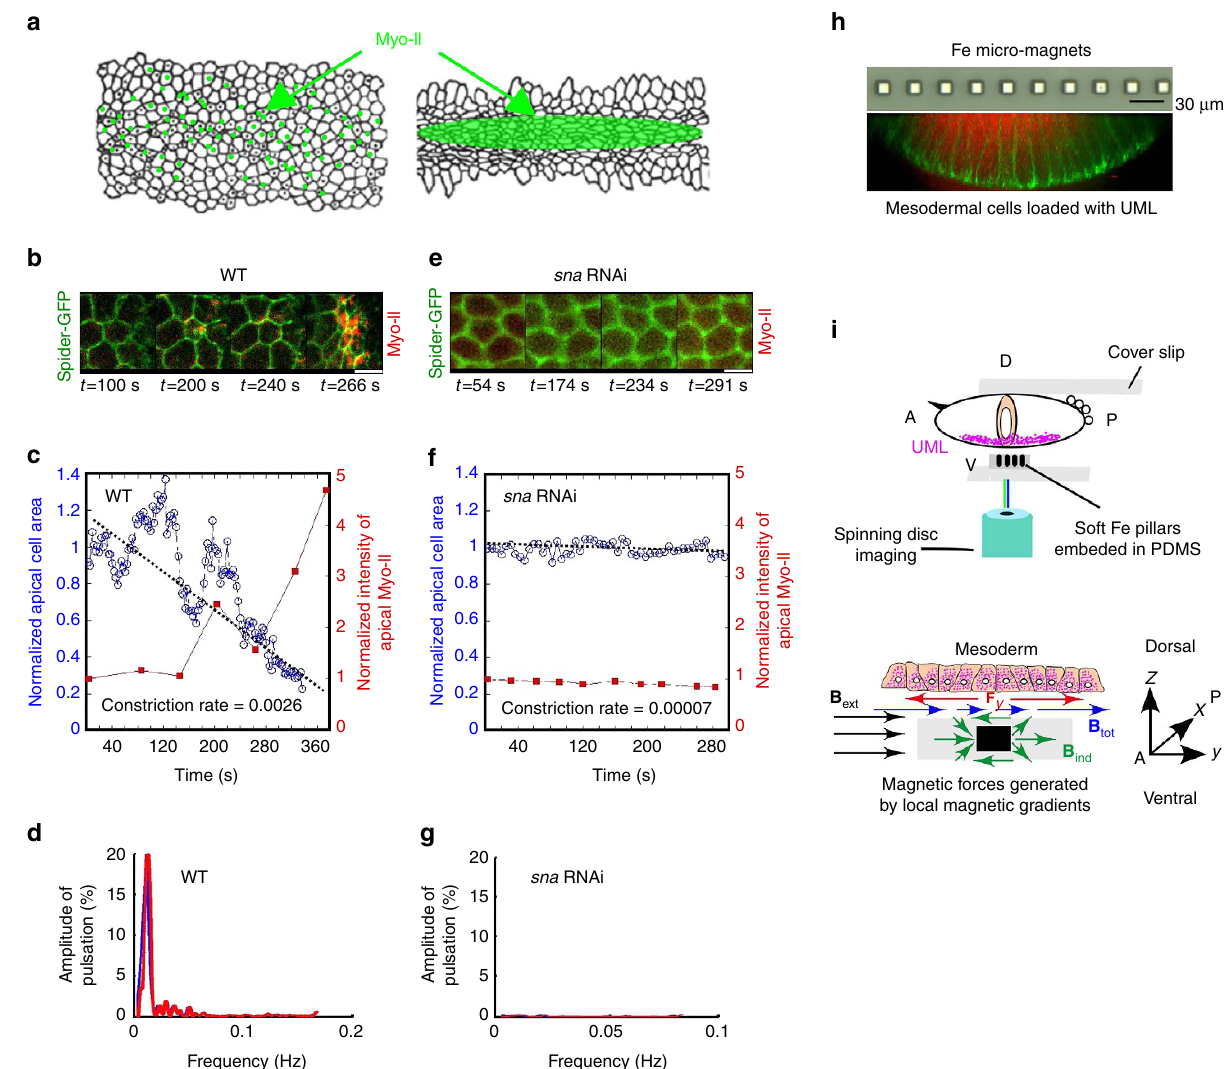
Figure 1 | Use of magnetic forces to mimic sna -dependent apex pulsations in mesoderm cells. ( a ) Snail-dependent stochastic fluctuation of mesoderm apex size followed by the medio-apical accumulation of Myo-II. ( b ) Apex size pulsations imaged in the time range 100–240s, followed by cell constriction (image at 266s) monitored using Spider–GFP (in green), with submembrane apical accumulation of Myo-II (sqh–mCherry in red). ( c ) Variation of the apical surface area (in blue) and Myo-II concentration (in red) as a function of time in the WT. Representative of the n ¼ 10 quantified on the N ¼ 64 pulsating cells, of the 587 mesoderm cells observed, in six distinct embryos. ( d ) Spectral signature of sna -dependent pulsations in the WT before stable constriction, following Fourier transformation of c . Representative of the n ¼ 8 cells allowing analysis (that is, staying in the same focus plane long enough) on the N ¼ 64 pulsating cells of the 587 mesoderm cells observed in six distinct embryos. ( e ) Absence of cell pulsations, constriction and submembrane apical accumulation of Myo-II, in sna RNAi ( n ¼ 6 on N ¼ 6 embryos). ( f ) Variation of the apical surface area (in blue) and Myo-II concentration (in red) as a function of time in sna RNAi. Representative of the n ¼ 17 quantified cells of the 892 mesoderm cells observed in six distinct embryos. ( g ) Spectral signature of sna RNAi, following Fourier transformation of f . ( h ) Up: optical microscope image (reflection mode) of the micro-magnet network embedded in PDMS. Down: image of fluorescent UML (red) inside the basal domain of mesoderm cells, following the completion of cell formation at the end of stage 5. Green is Spider–GFP. ( i ) Up: schematic of the confocal-spinning disk microscope set-up in which the UML-loaded embryo is positioned on top of a transparent PDMS membrane containing a linear array of micro-magnets. Down: schematic of the homogeneous external magnetic field, B ext (in black) used to magnetize the soft micro-magnets, producing an inhomogeneous induced field, B ind (in green). The gradient of the induced field creates an in-plane tangential repulsive force F y (in red) on UML, magnetized by B tot (in blue). A is anterior and P is posterior. White scale bars are 5 m m.